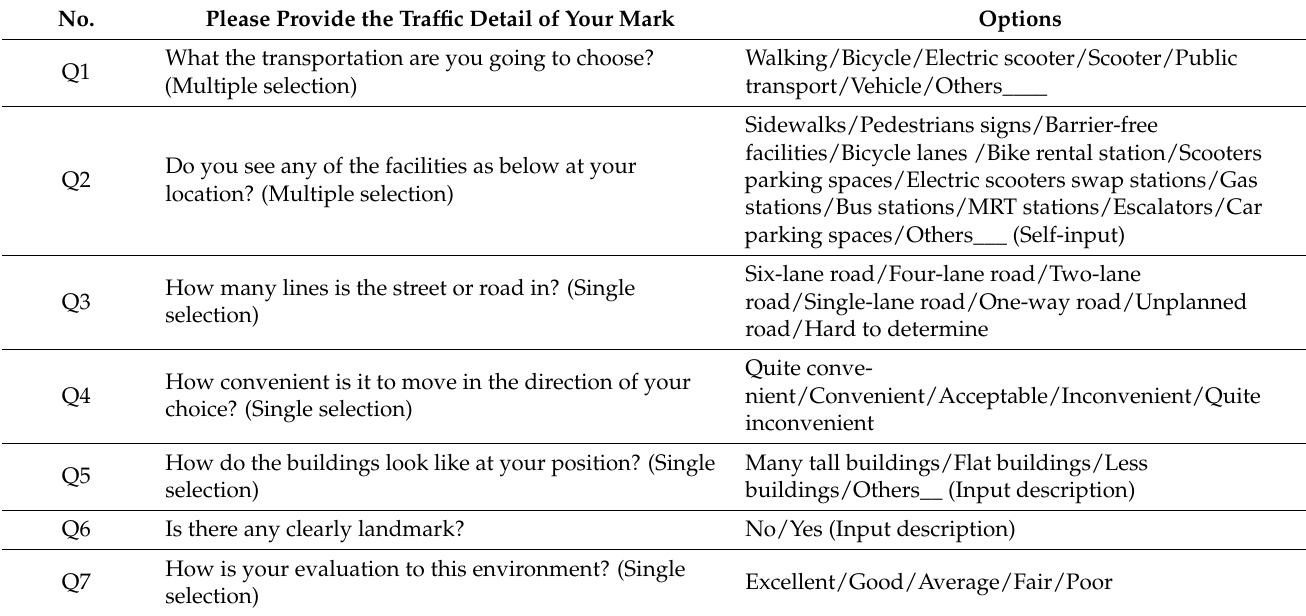
Table 2. Questionnaire used in extraction system to determine citizen feelings. This is the question- naire implemented in the check-in system on the website. Each selection sends a number to the database. For example, in Q7, when the user feels better in the environment, the number is bigger. All of the numbers are integers.